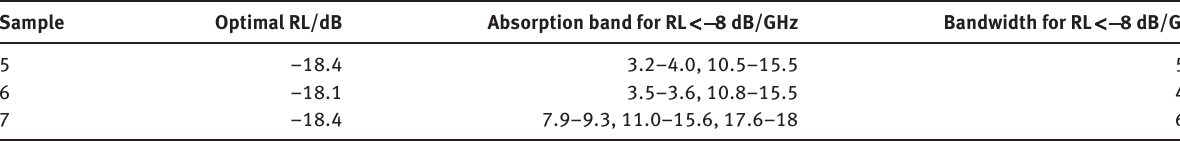
Table 4: Detailed data of double-layer cement composites with different replacement levels of FA in the absorbing layer. Sample